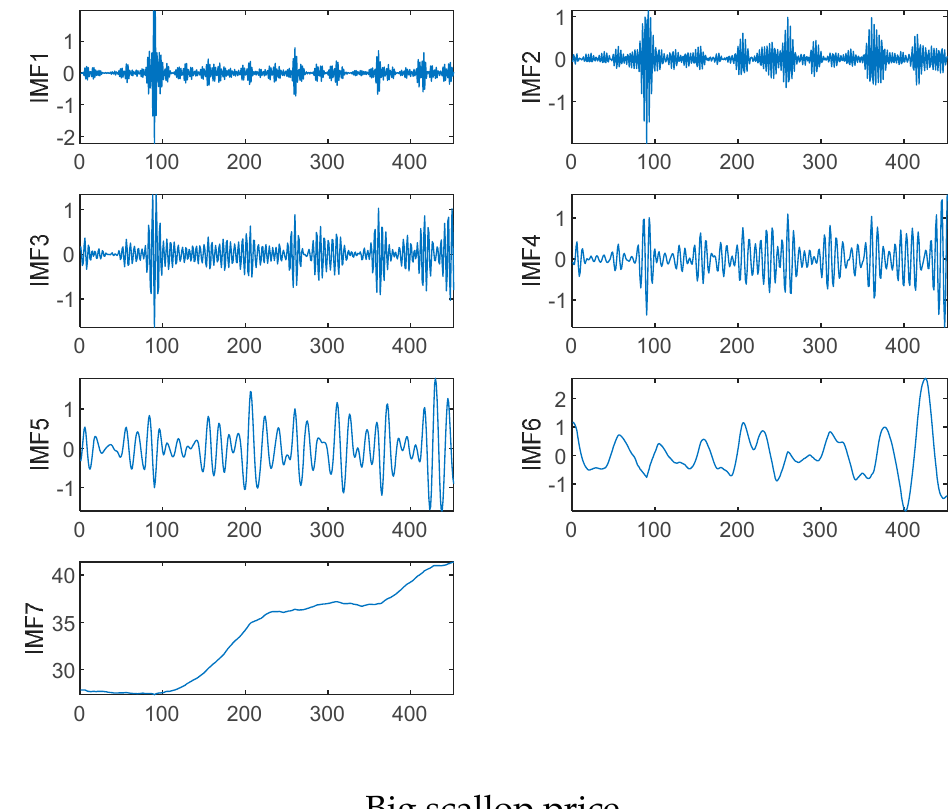
Figure 5. The outcome of VMD for each aquatic product price dataset.